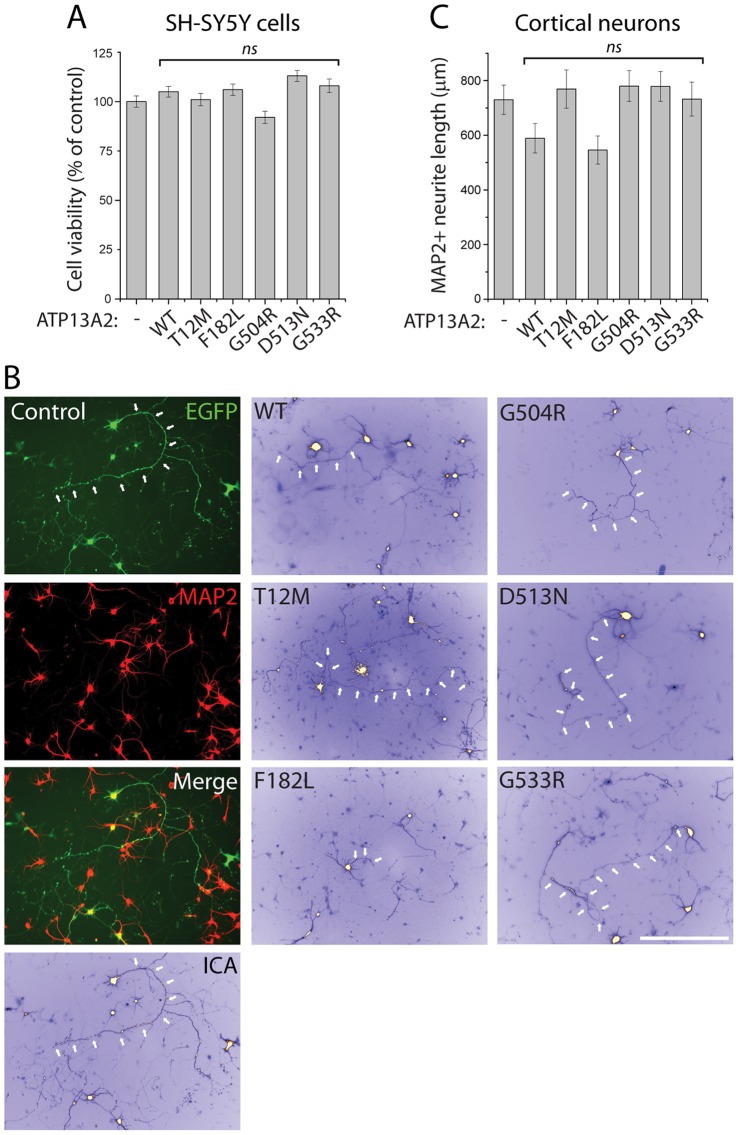
Overexpression of ATP13A2 impairs neurite outgrowth of cortical neurons. A
, Viability of SH-SY5Y cells transiently expressing V5-tagged human ATP13A2 variants at 48 h post-transfection assessed by MTS assay. Bars represent mean±SEM (n = 4 experiments). B, Rat primary cortical neurons co-transfected at DIV 3 with V5-tagged human ATP13A2 variants (or control empty vector) and EGFP plasmids at a DNA molar ratio of 10∶1. Cultures were fixed at DIV 6. Representative fluorescent micrographs reveal the co-labeling of cortical neurons with EGFP and MAP2 for each condition. EGFP images representing ATP13A2-positive cortical neurons were pseudo-colored with ICA to improve the contrast of neuritic processes for length measurements. Axonal processes are indicated with arrows. Scale bar: 400 µm. C, Analysis of the length of EGFP+/MAP2+ neurites from rat primary cortical neurons expressing V5-tagged human ATP13A2 variants (or control empty vector). Expression of WT or F182L ATP13A2 produces a non-significant shortening of cortical axonal processes compared to control neurons expressing EGFP alone. Bars represent the length of MAP2+ neurites in µm (mean±SEM; n = 67–88 neurons from three independent cultures). Non-significant (ns) compared to control (-) by one-way ANOVA with Newman-Keuls post-hoc analysis.